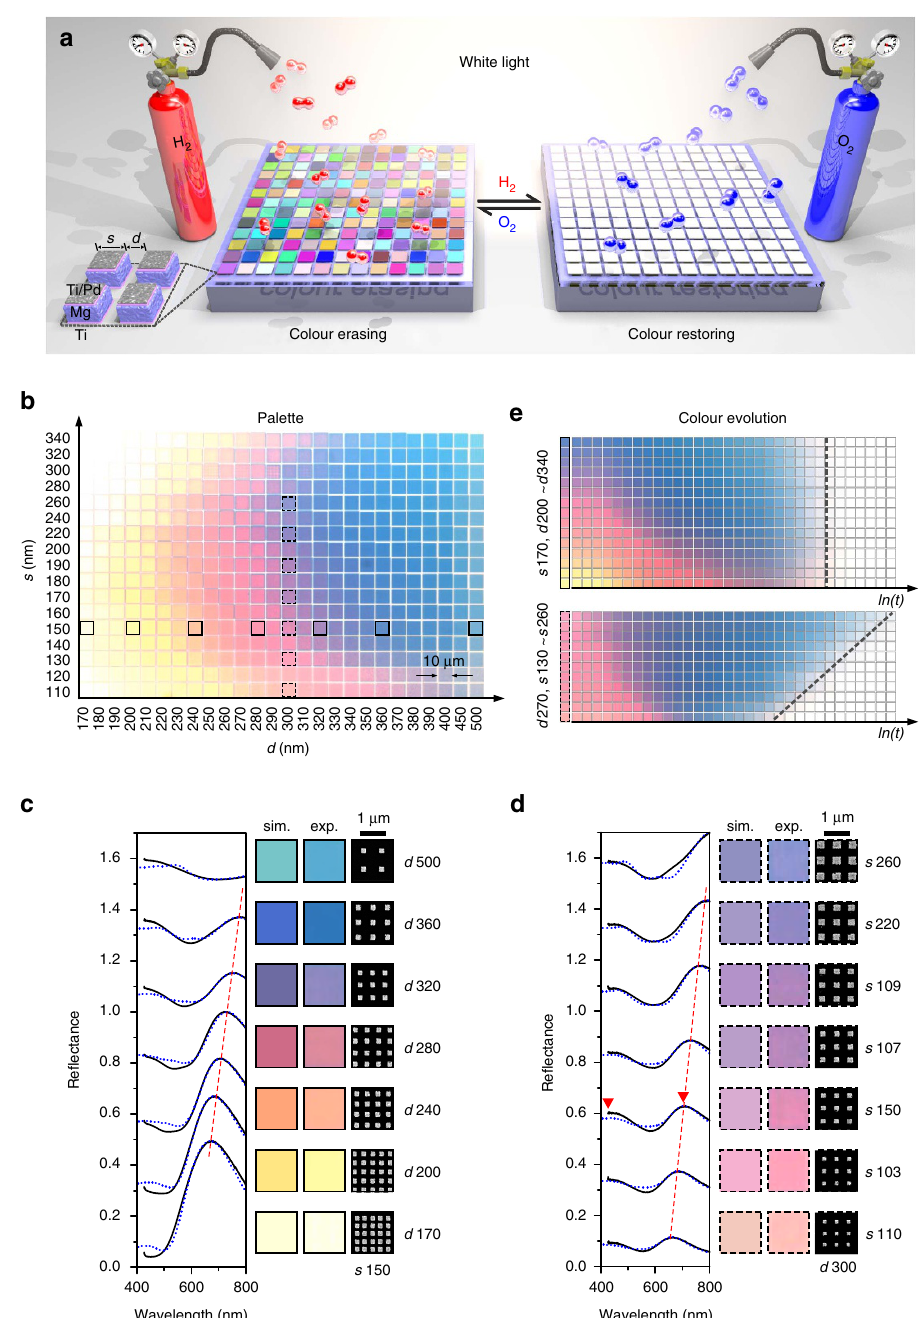
Figure 1 | Working principle and optical characterization of the dynamic plasmonic colour display. ( a ) Schematic of the plasmonic metasurface composed of hydrogen-responsive Mg nanoparticles interacting with incident unpolarized white light. These Mg nanoparticles are sandwiched between Ti/ Pd capping layers and a Ti adhesion layer. In each colour square (10 m m), they are arranged in a lattice with a period of s þ d along both directions. s and d are the size of the square-shaped particles and the interparticle distance, respectively. The colours of the plasmonic metasurface can be erased upon hydrogen exposure through phase-transition from Mg to MgH 2 . The colours can be restored upon oxygen exposure through transformation of MgH 2 back to Mg. ( b ) Colour palette obtained by stepwise tuning of s and d . ( d ) Experimental (black) and simulated (blue-dotted) reflectance spectra of the colour squares selected from b . The spectral curves are shifted upwards for clarity. In ( c ) and ( d ), the selected colours correspond to those indicated using solid (dashed) squares along the horizontal (vertical) direction in b . Experimental and simulated colours as well as the corresponding SEM images of the structures. The red dashed line indicates the shift of the reflectance peak. ( e ) Colour evolutions of the selected colour squares upon hydrogen exposure over time ln (t) . The grey-dashed lines indicate the colour vanishing times in the two